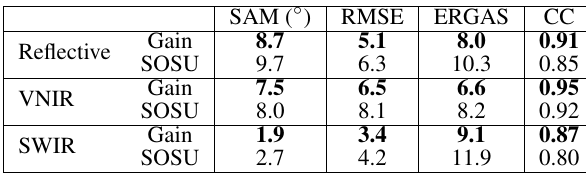
Table 2. Criteria computed on mixed pixels reorganised with combinatory analysis